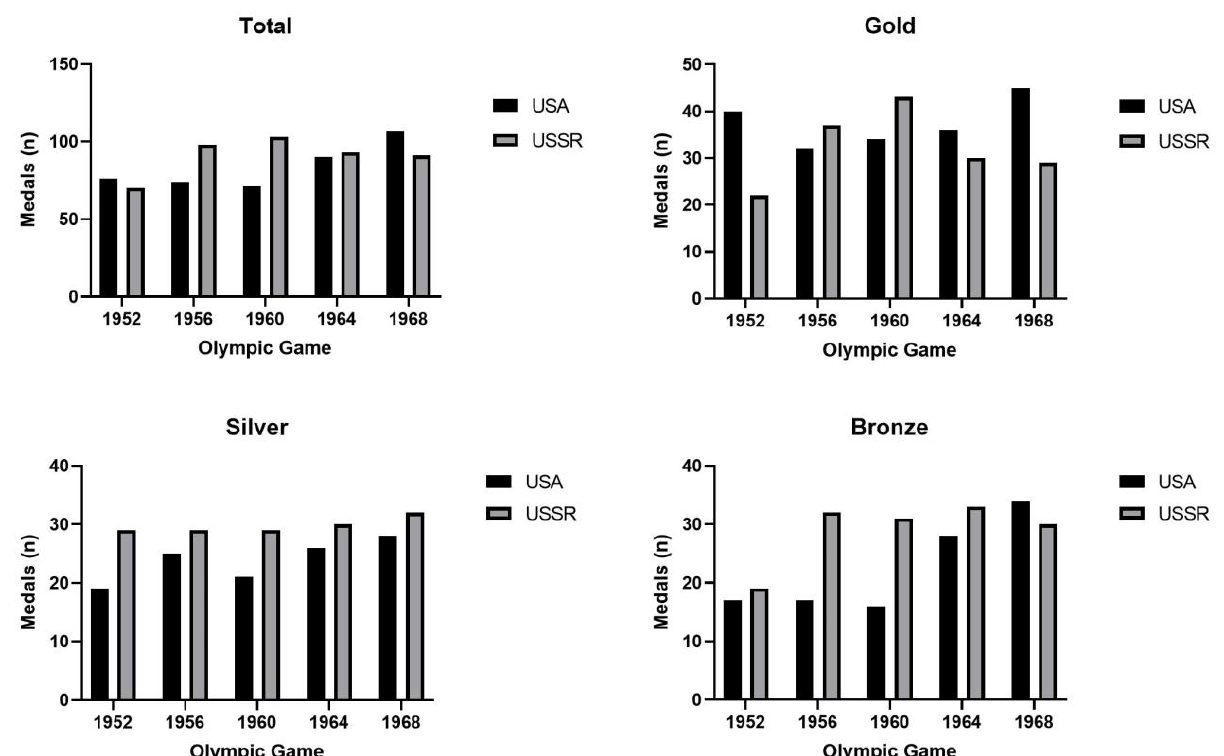
Figure 1. Medals in the Olympic Games from 1952 to 1968 [16].